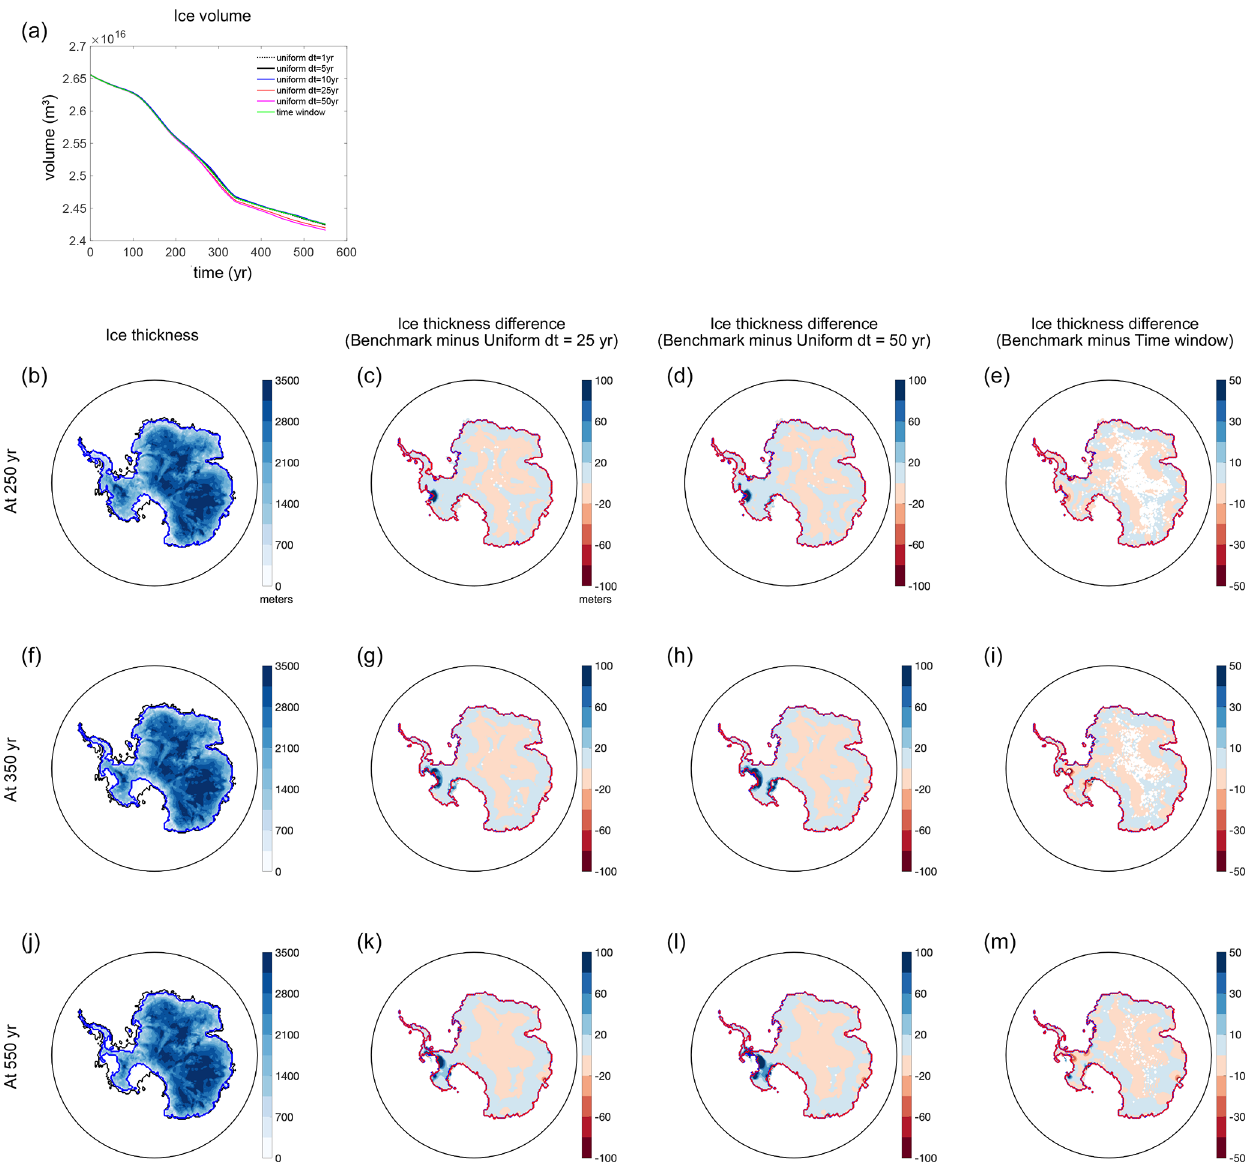
Figure 9. Changes in Antarctic Ice Sheet volume and thickness from coupled ice-sheet–sea-level simulations over 550 years adopting a RCP 8.5 scenario from DeConto et al. (2021). (a) AIS volume variations through 550 years from simulations that incorporate uniform (standard) coupling intervals of 1 (benchmark), 5, 10, 25 and 50 years and that incorporate the time window profile derived in Fig. 7. (First column) Ice thickness modelled in the benchmark simulation and differences in ice thickness between the benchmark and the standard simulations that incorporate coupling interval of (second column) 25 years and (third column) 50 years and that incorporates (fourth column) the time window profile. Each row shows results at a different simulation time at (b–e) 250 years, (f–i) 350 years and (j–m) 550 years. Note that the colour bars are saturated in the second and third column